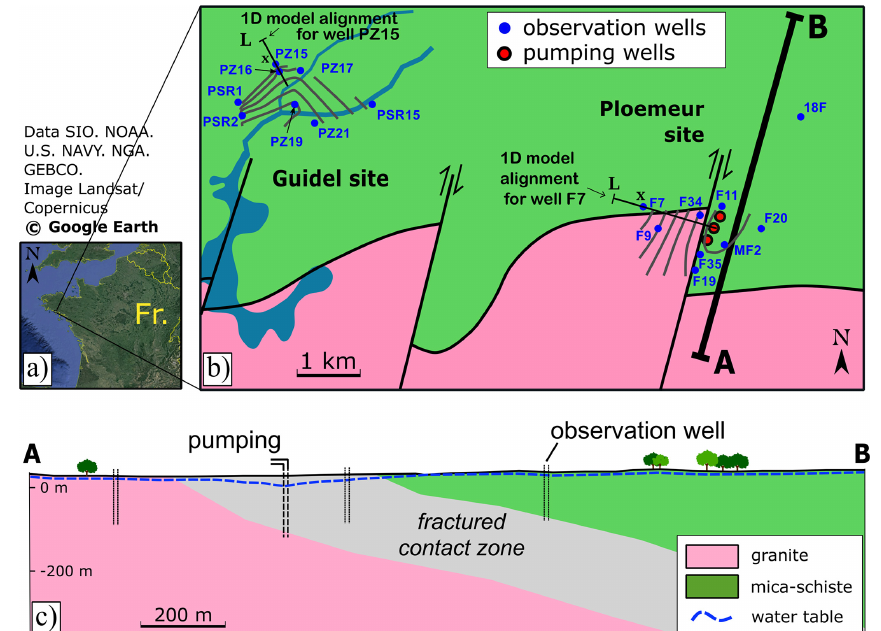
Figure 2. Schematic of Ploemeur and Guidel sites. (a) Field sites location in France. (b) Geological map and location of monitoring (blue points) and pumping wells (red points) (modified from Ruelleu et al., 2010). Mean GW level measured over the piezometric network is represented by gray equipotential lines. For each site, one 1D model is illustrated by a black line. (c) South–north cross section of the Ploemeur site. Wells are generally screened over depths ranging from 30 to 100m. Dashed blue line represents groundwater